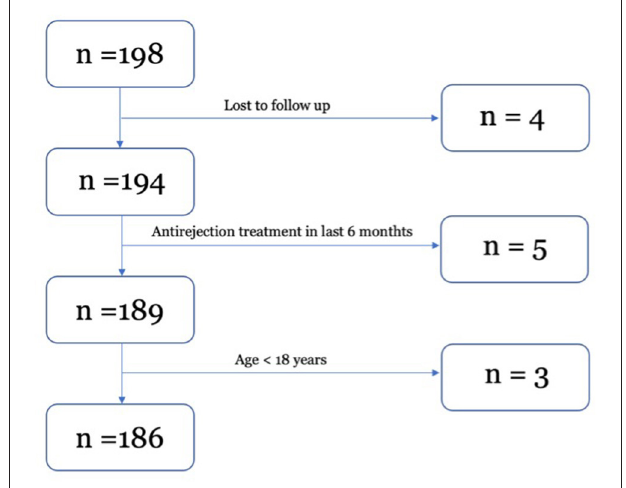
FIGURE 1 | Flowchart of the